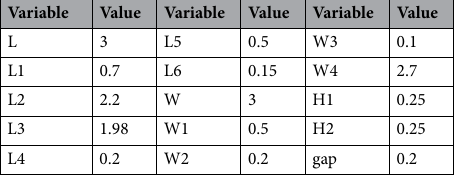
Table 1. The parameters of the proposed antenna (Unit: